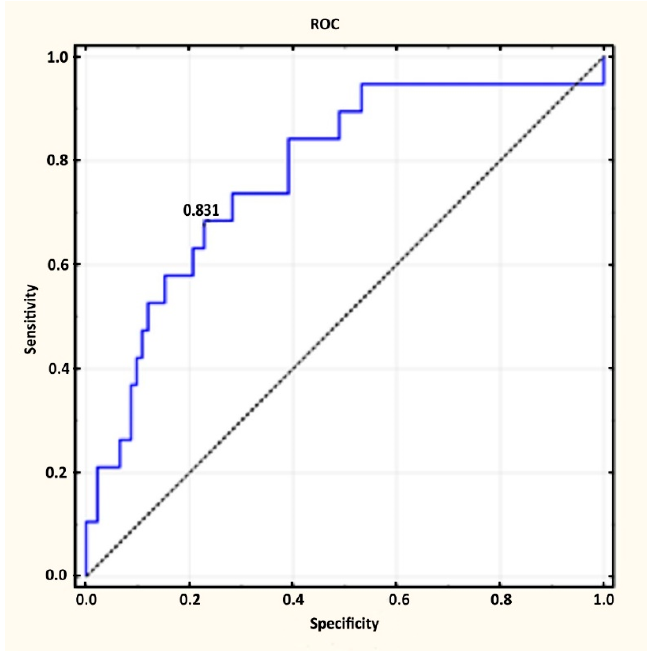
Figure 1. Suggested cut-off point to determine patients with or without isolated local recurrence.